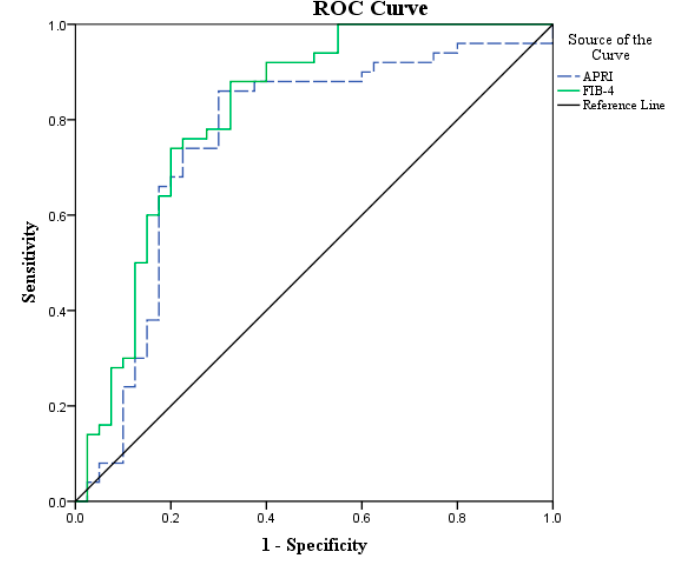
Figure 3. Receiver Operating Characteristics (ROC) curve for aspartate aminotransferase to platelet ratio index (APRI) and Fibrosis index based on the 4 factors (FIB-4) in hepatocellular carcinoma patients vs. cirrhotic patients and control group.